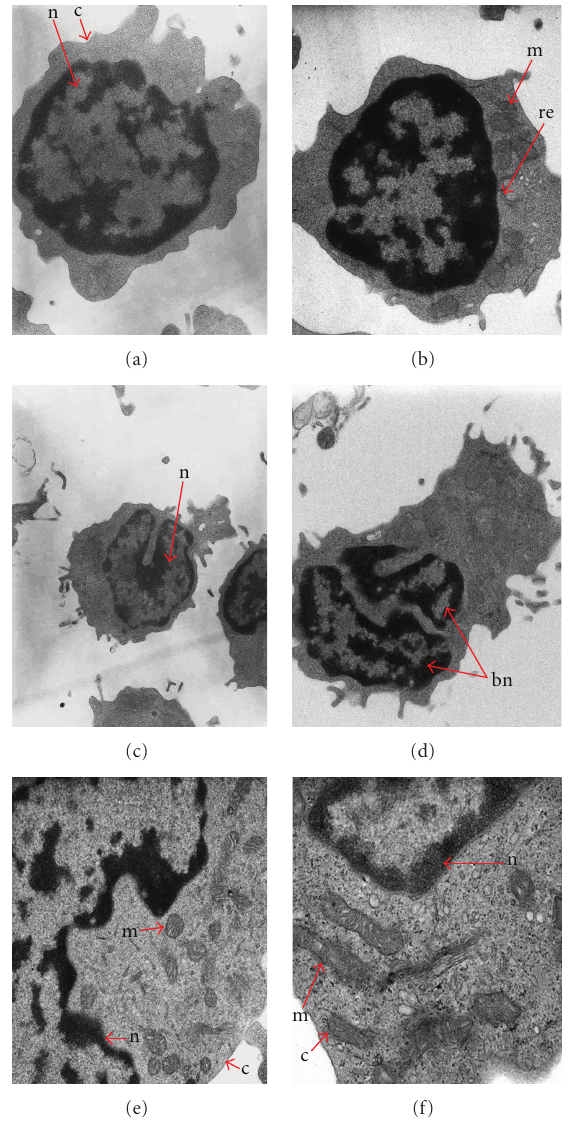
Figure 1: Evaluation of LCL’s transformation by electron mi- croscopy: (a) (0.5 μ m), (b) (0.5 μ m), (e) (1 μ m)—Lymphocytes before transformation. (c) (300nm), (d) (300nm), (f) (1 μ m)— Lymphocytes after transformation. Bn: binucleation, c: cytoplasm, m: mitochondria, n: nucleus, re: endoplasmic reticulum.